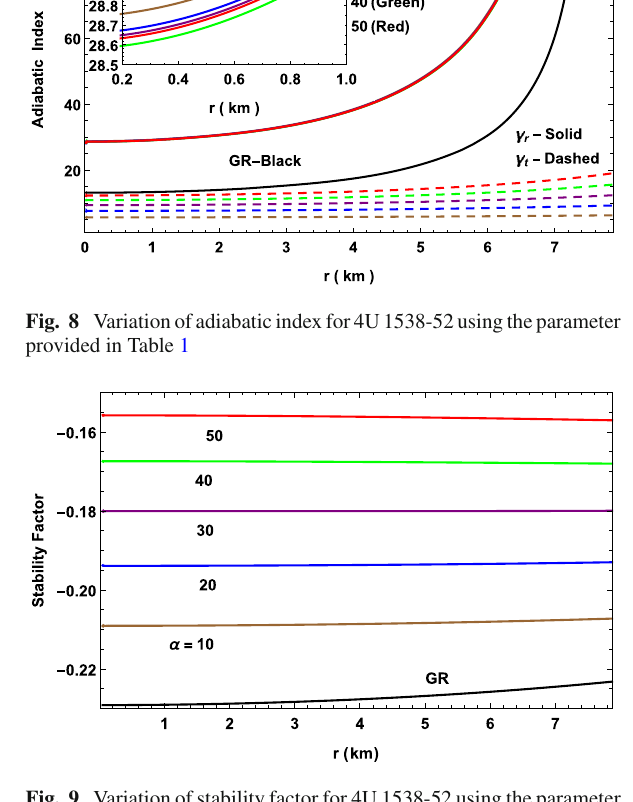
Fig. 9 Variation of stability factor for 4U 1538-52 using the parameter provided in Table